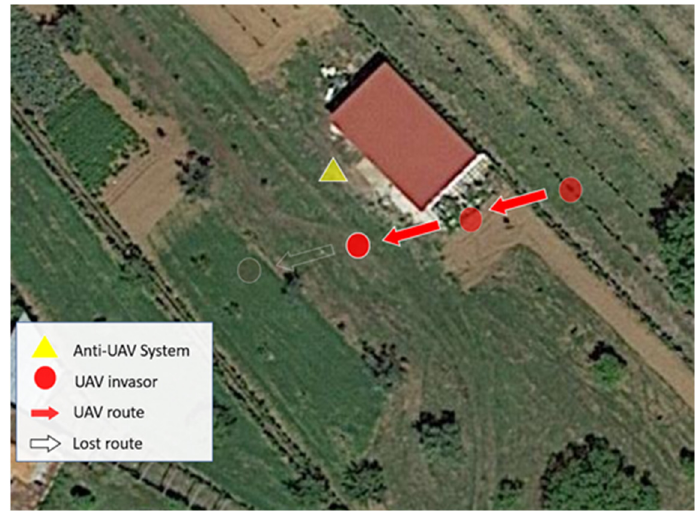
Figure 13. Real test scenario using jamming signals.